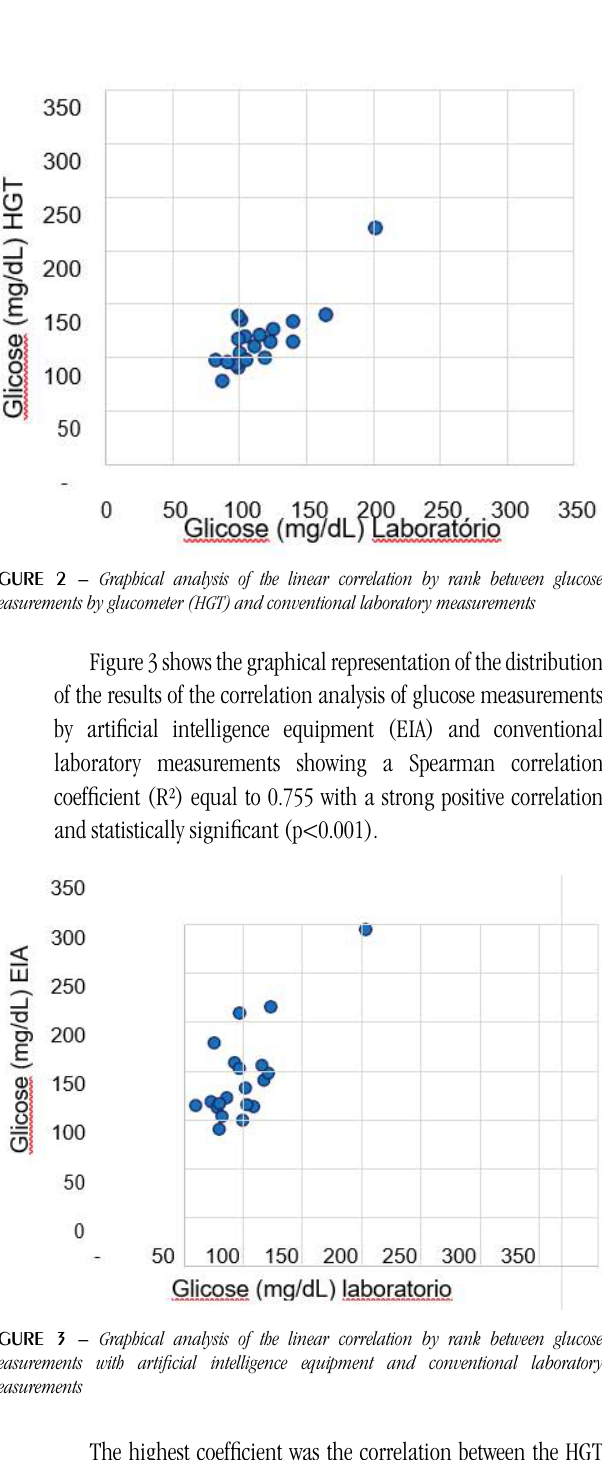
fIGuRE 3 – Graphical analysis of the linear correlation by rank between glucose measurements with artificial intelligence equipment and conventional laboratory measurements